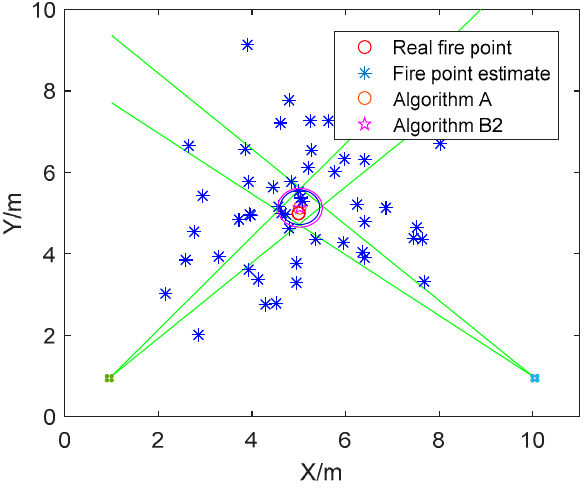
Figure 4. The circular fire source arrangement solved by Algorithm A and Algorithm B2. Table 4 The circle centers of real fire points and its estimates by Algorithms A and B2.